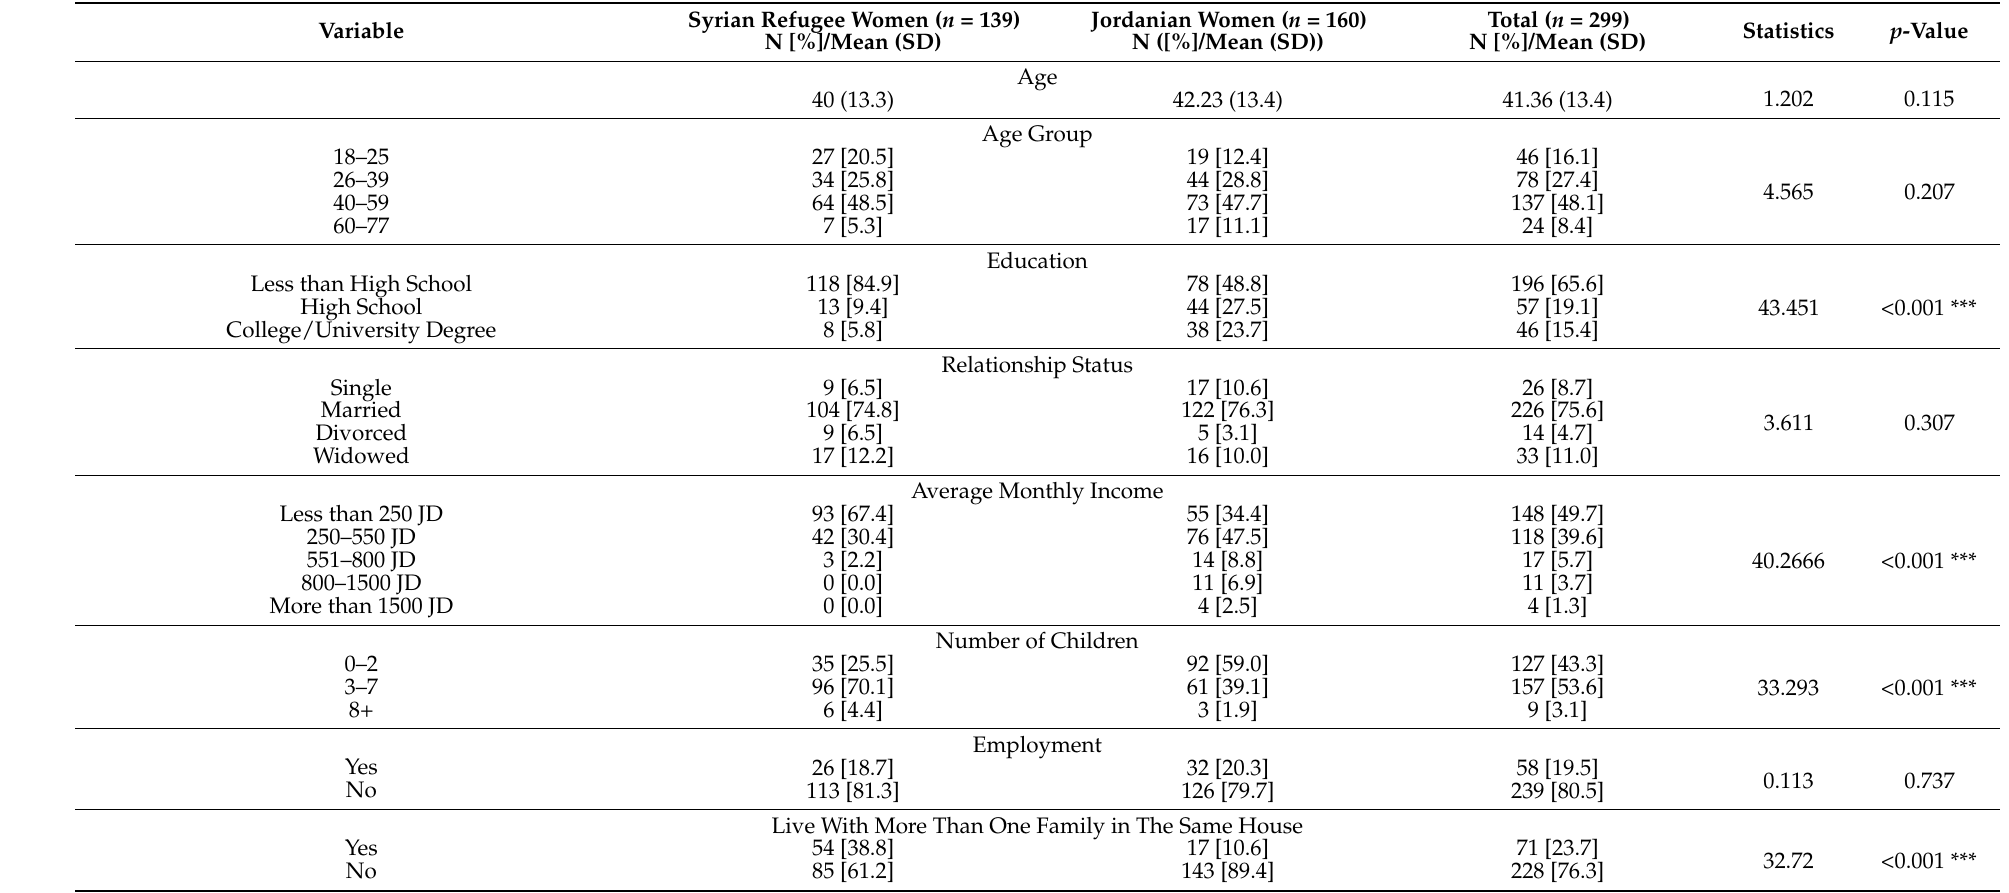
Table 1. Sociodemographic characteristics and mental health scale scores of Syrian refugee and Jordanian women.